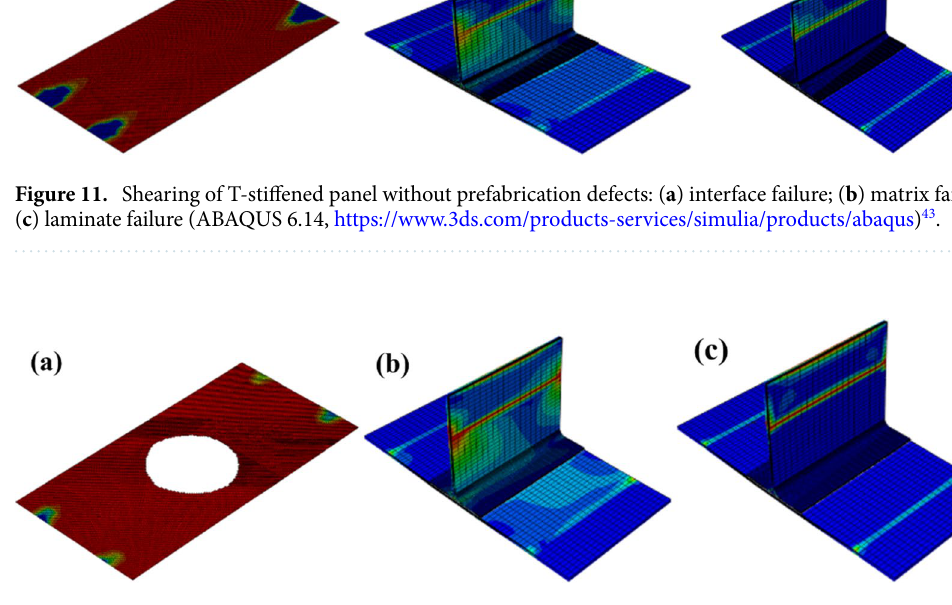
Figure 12. Shear of T-stiffened panel with prefabricated defects: ( a ) interface failure; ( b ) matrix failure; ( c ) laminate failure (ABAQUS 6.14, https:// www. 3ds. com/ produ cts- servi ces/ simul ia/ produ cts/ abaqus) 43 .